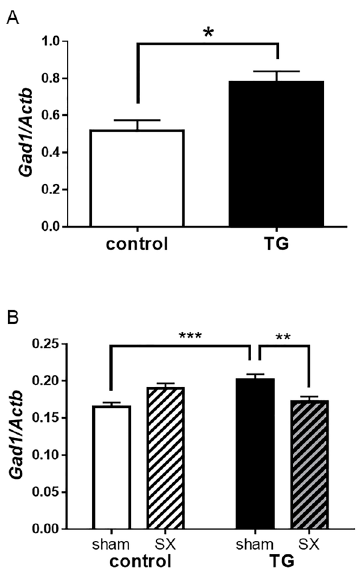
Figure 7. Expression of Gad1 in the hippocampus. ( A ) Glutamate decarboxylase 1 ( Gad1 ) mRNA levels were quantified by real-time PCR and normalized to β -actin ( Actb ) mRNA levels. In transgenic (TG) mice, Gad1 expression levels were significantly increased compared with C57BL/6 control mice. Each bar represents mean ± SEM of C57BL/6 control mice ( n = 6) or TG mice ( n = 6); * p < 0.05, Student’s t -test; ( B ) Expression of Gad1 was significantly decreased in sialoadenectomized TG mice to similar levels as C57BL/6 control mice. Each bar represents mean ± SEM of C57BL/6 control mice ( n = 6) or TG mice ( n = 6); ** p < 0.01, *** p < 0.001, two-way ANOVA followed by Tukey’s test. sham: sham- operated mice; SX: sialoadenectomized mice.